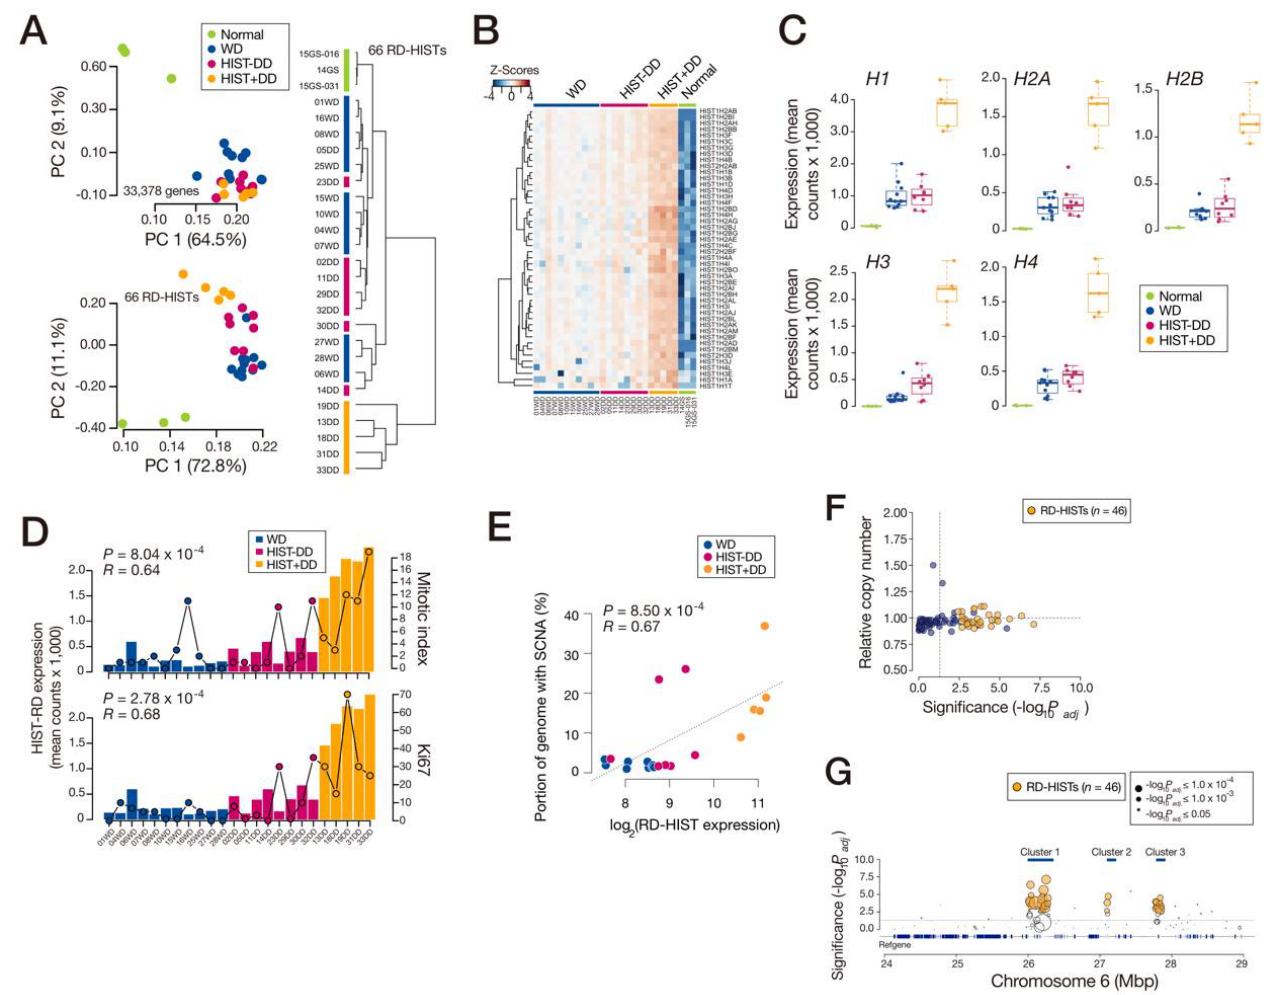
Figure 2. RD-HIST overexpression in a subset of DDLPS samples. ( A ) PCA plot using the entire gene set (upper) and 66 RD-HIST genes (bottom). ( B ) Heatmap of the LPS samples using 66 RD-HIST genes. ( C ) Expression of RD-HIST from RNA-seq transcripts divided by histone types. ( D ) Correlation between RD-HIST expression and cell proliferation indices of the tumor samples. ( E ) Correlation between RD-HIST expression and occurrence of SCNA in the genome. ( F ) Copy-number changes in the genomic interval encompassing the RD-HIST clusters. ( G ) Histone gene-specific differential expression in the cluster. Numbers of samples used for ( A – C ): n = 27 (WD: 11, HIST-DD: 8, HIST + DD: 5, and normal: 3), ( D , E ): n = 24 (WD: 11, HIST-DD: 8, and HIST + DD: 5). HIST + DD: histone-positive DDLPS, and HIST-DD: histone-negative DDLPS.